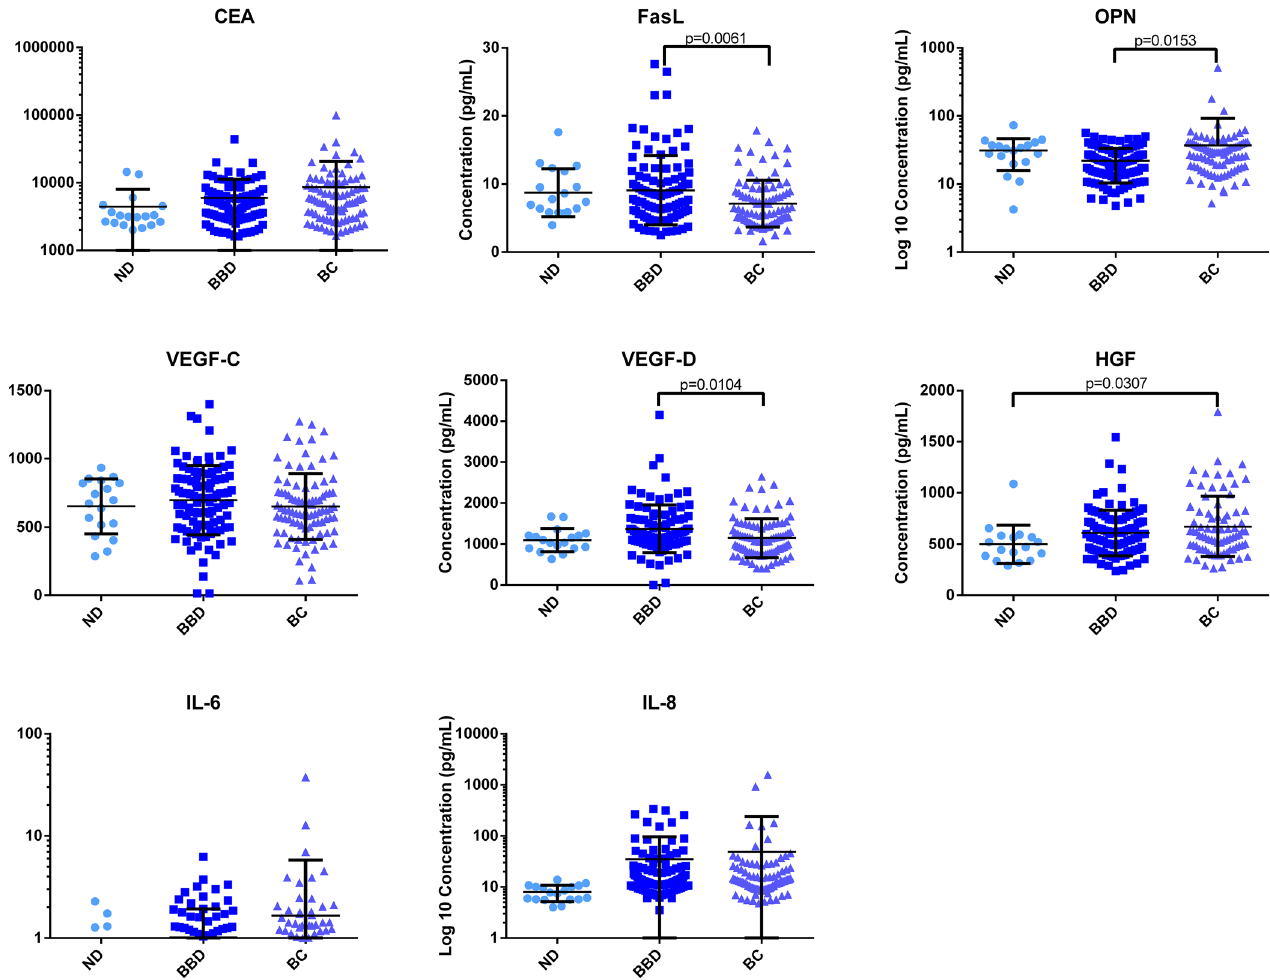
Fig 1. SPB Expression across Patient Groups. Shown is the comparison of no disease (ND), benign breast disease (BBD), and breast cancer (BC) samples. Graphs may be shown with y-axis represented as concentration (in pg/mL) or Log 10 concentration in order to better view analytes with wide distributions in the study